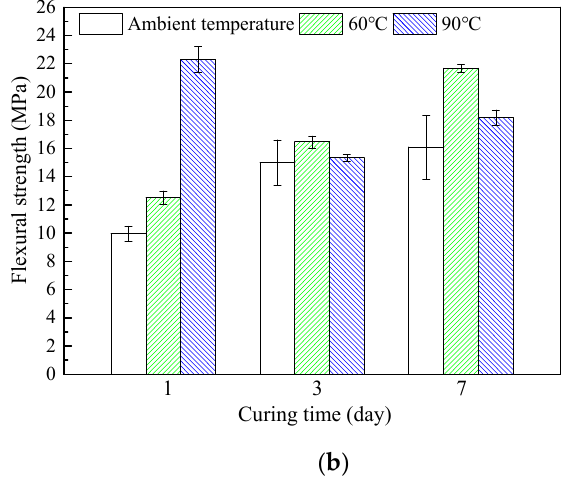
Figure 6. Flexural strength of HMGC under different curing conditions. ( a ) HMGC without steel fibers cured at different temperatures; ( b ) HMGC with steel fibers cured at different temperatures.